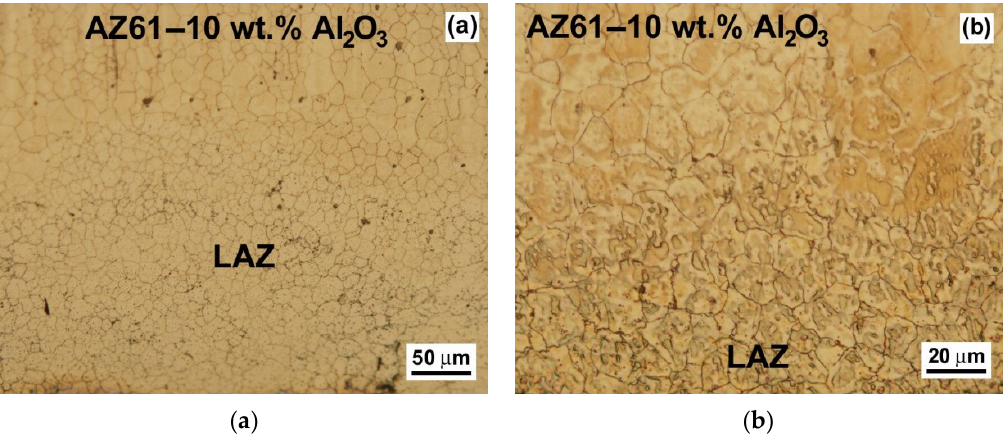
Figure 4. Detailed light-optical micrographs of the LAZ microstructure created using currently optimized laser surface treatment of AZ61–10 wt.% Al 2 O 3 nanocomposite: ( a ) whole LAZ microstructural gradient and ( b ) interface between the LAZ and AZ61–10 wt.% Al 2 O 3 composite.